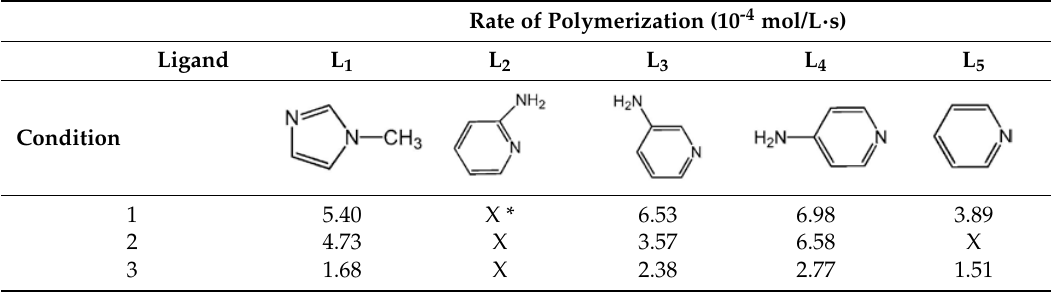
Table 2. Effects of chemical structure of ligands on the rate of polymerization.